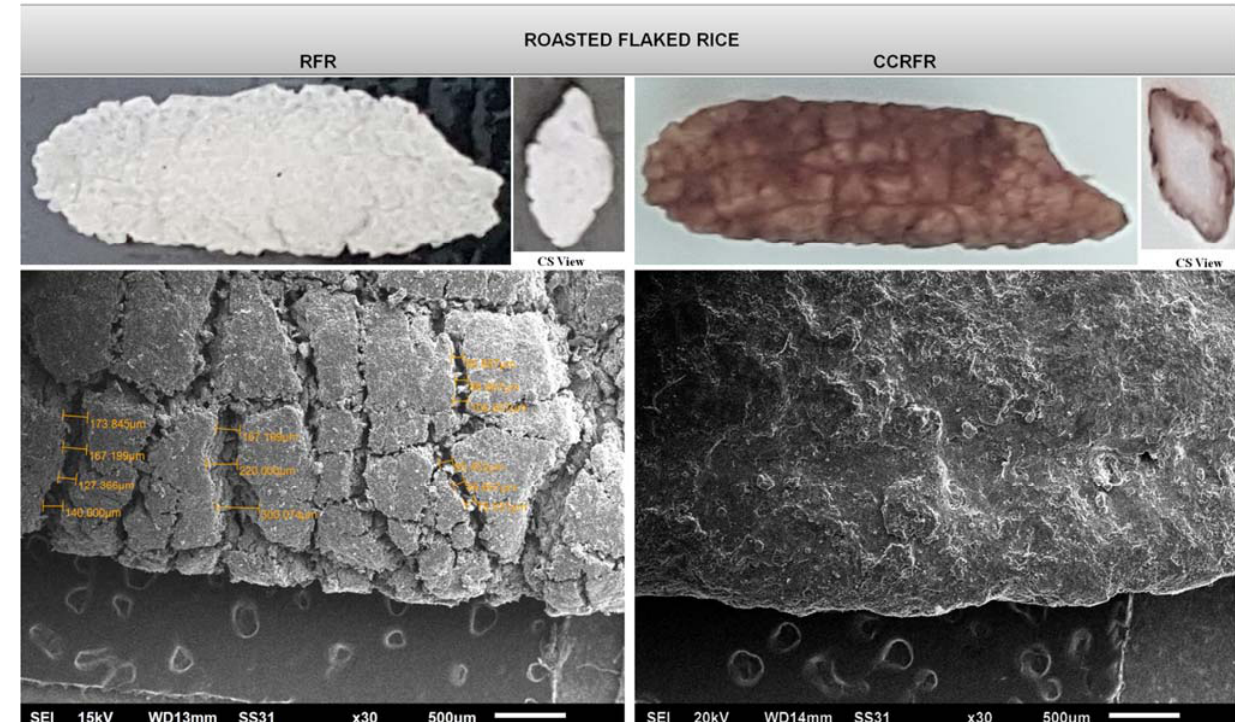
Figure 6. Micrographs of RFR and CCRFR.